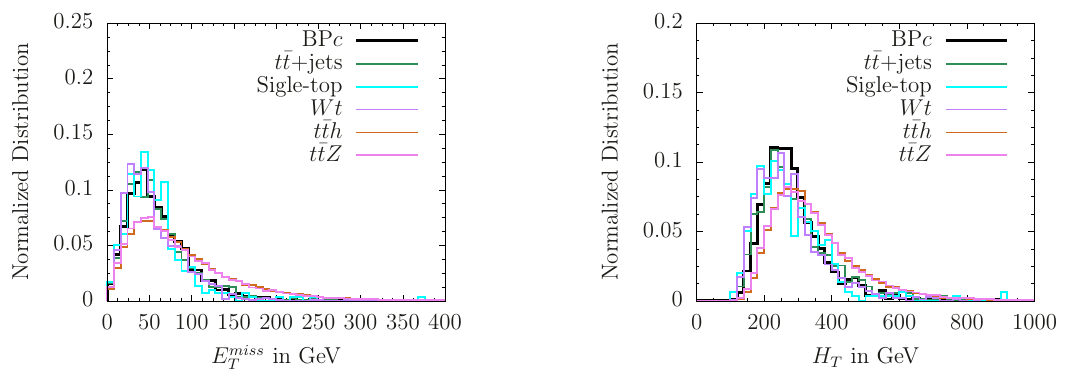
(left) and H T (right) for the signal (BP c ) and T